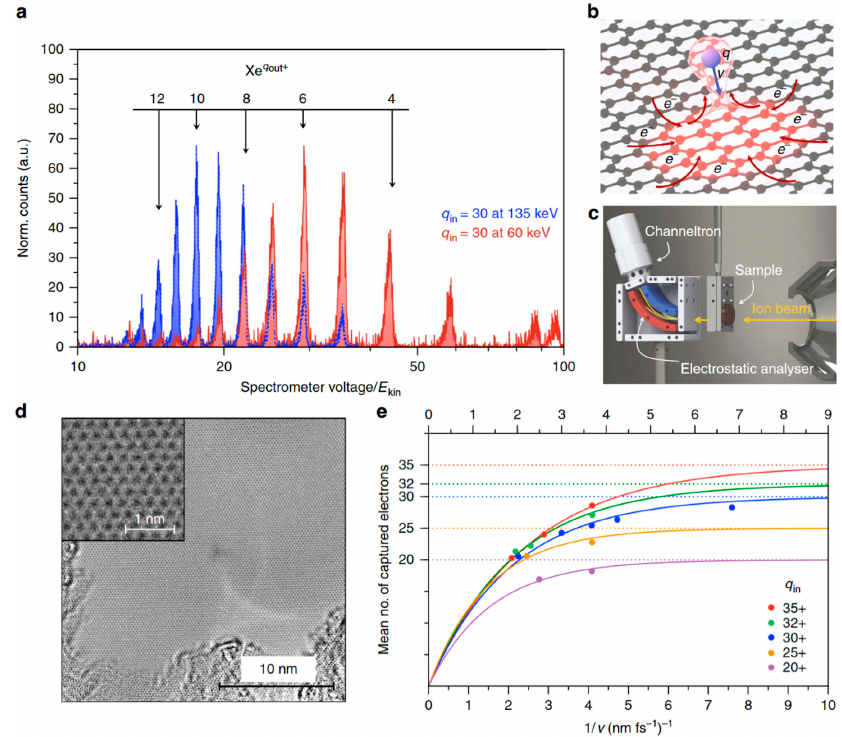
Figure 5. Experimental scheme and results. ( a ) Measured spectra of a Xe 30+ beam at kinetic energies of 135 and 60 keV (blue and red, respectively) transmitted through a freestanding single-layer graphene (SLG) sheet with different amount of charge injected ( q in ). Exit charge states out q are calculated from the spectrometer voltage of the electrostatic analyzer. The exit charge state distribution shifts towards smaller average exit charge out q for slower ions. ( b ) Schematic of the interaction process between freestanding SLG and an approaching highly charged ion (HCI). The HCI extracts a lot of charge from a very limited area on the femtosecond time scale, leading to a temporary charge-up of the impact region ( q is the amount of electricity, and v is the speed.). ( c ) Sketch of the experimental setup with the target holder and electrostatic analyzer. ( d ) TEM image of a freestanding monolayer of graphene after irradiation with Xe 40+ ions at 180 keV with an applied fluence of 10 12 ions per cm 2 (about six impacts on the shown scale). No holes or nanosized topographic defects could be observed. ( e ) Average number of captured and stabilized electrons ( in out q q − ) after transmission of qin Xe + ions through a single layer of graphene as a function of the inverse projectile velocity for different incident charge states [56]. Copyright 2016, Springer Nature. 3.5. Novel Electrical Properties of Graphene/Graphene van der Waals Heterostructure A van der Waals (VdW) heterostructure is a vertical stack of two-dimensional materials. Based on the rich functionality of two-dimensional materials, more engineering manipulation can be realized to obtain unexpected new characteristics. The graphene-based van der Waals heterostructure is introduced as a substrate from h-BN (hexagonal Boron Nitride). The peculiar physical and chemical characteristics of the heterogeneous structure have provoked much interest. Of the many VdW